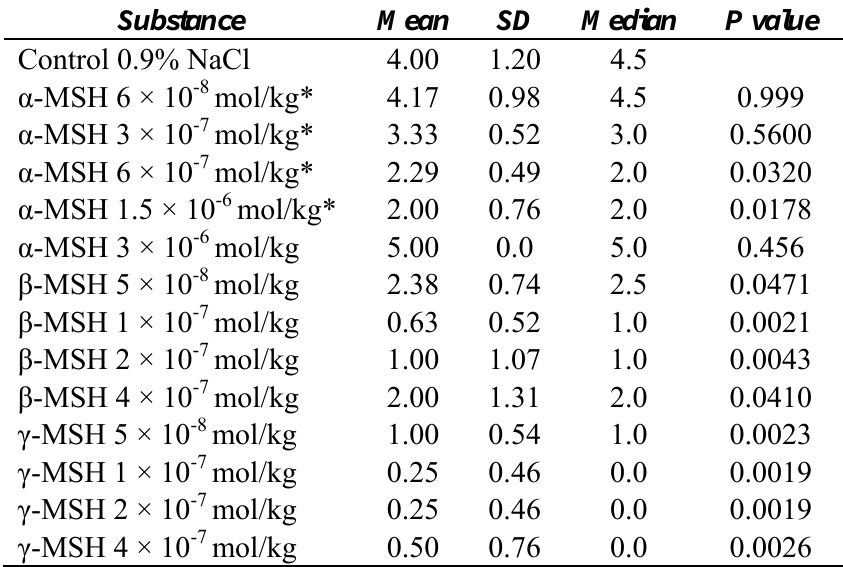
Table 4. Intensity of liver lesions 24 h after acetaminophen administration (150 mg/kg i.g.). Tested substances were given intraperitoneally 1 h before acetaminophen. P value is a result of comparison with the control group (Steel’s test).